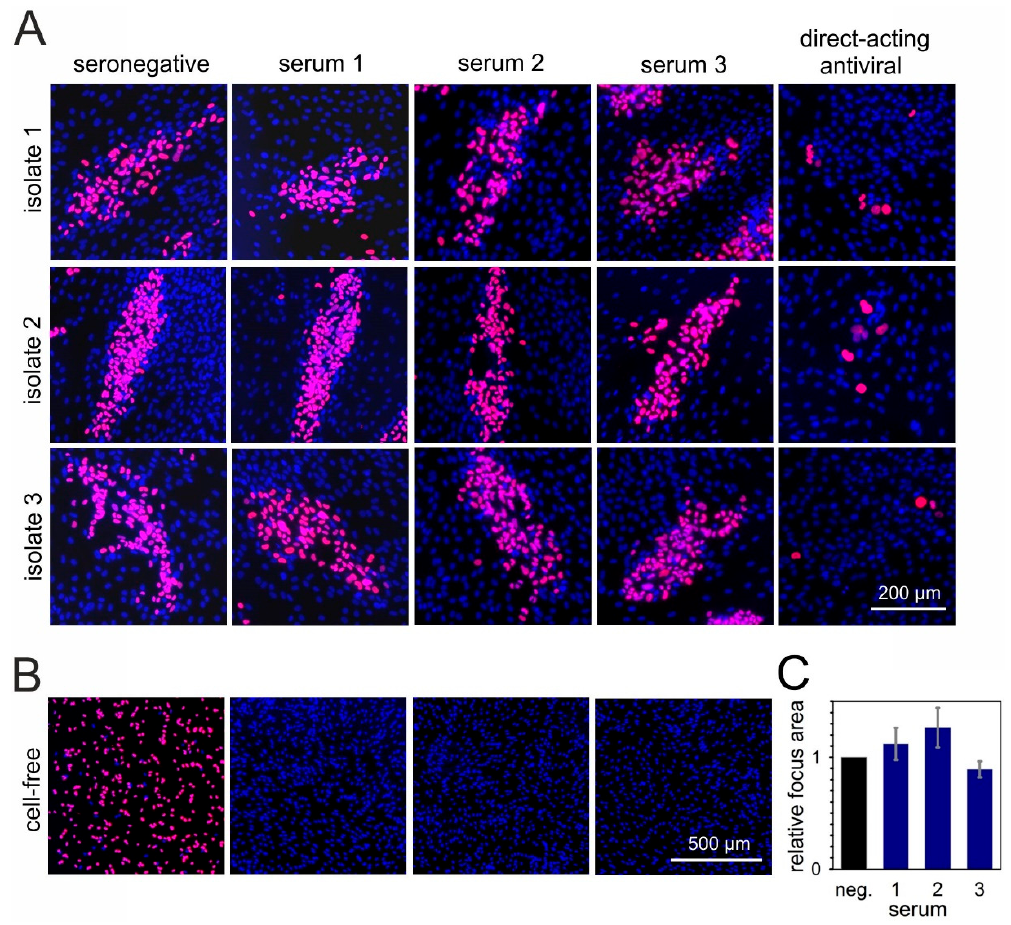
Figure 3. Sera with highly neutralizing capacity against cell-free HCMV transmission cannot inhibit cell-associated spread of clinical isolates in fibroblasts. ( A ) Fibroblasts infected with cell-associated clinical HCMV isolates were cocultured with an excess of uninfected HFFs, and, the following day, sera with highly neutralizing capacity against cell-free HCMV transmission were added to the coculture. Addition of seronegative human serum or a direct-acting antiviral served as a negative or positive control, respectively. Cocultures were then incubated for six days more to allow for cell-associated viral spread, followed by fluorescence staining for viral IE antigens (red signal). Nuclei of cells were stained with DAPI (blue signals). Three representatives out of six tested sera are shown. ( B ) To prove their neutralizing capacity, sera were mixed with HCMV-TB40/E-BAC4 (MOI 1) and incubated for 2 h. Fibroblasts were then infected with the serum-virus mixture. The next day, IE antigens were detected via indirect immunofluorescence staining (red signals). ( C ) For the three sera shown in panel A, focus areas were determined and compared with the negative control. For each serum, the bar represents the mean value of the three isolates (four to seven foci evaluated per isolate). Error bars represent the SEM.